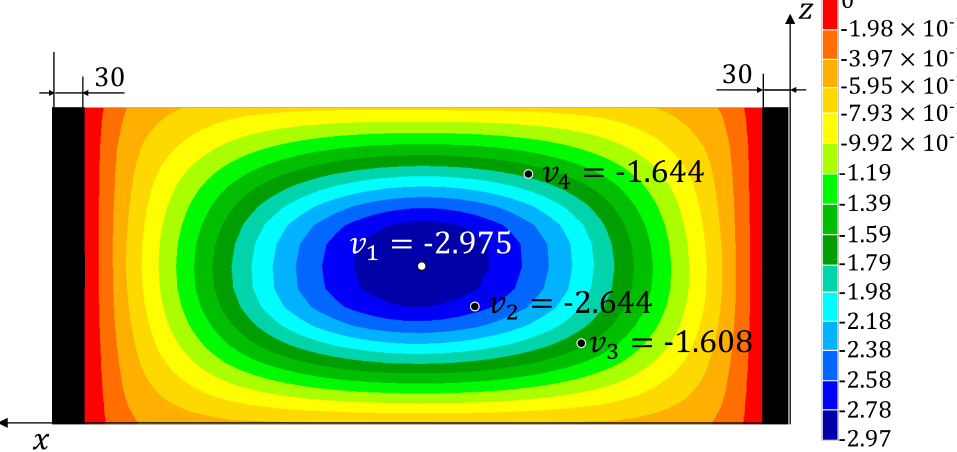
Figure 13. Test 3—Transverse displacement contour for the iFEM with all dimensions in